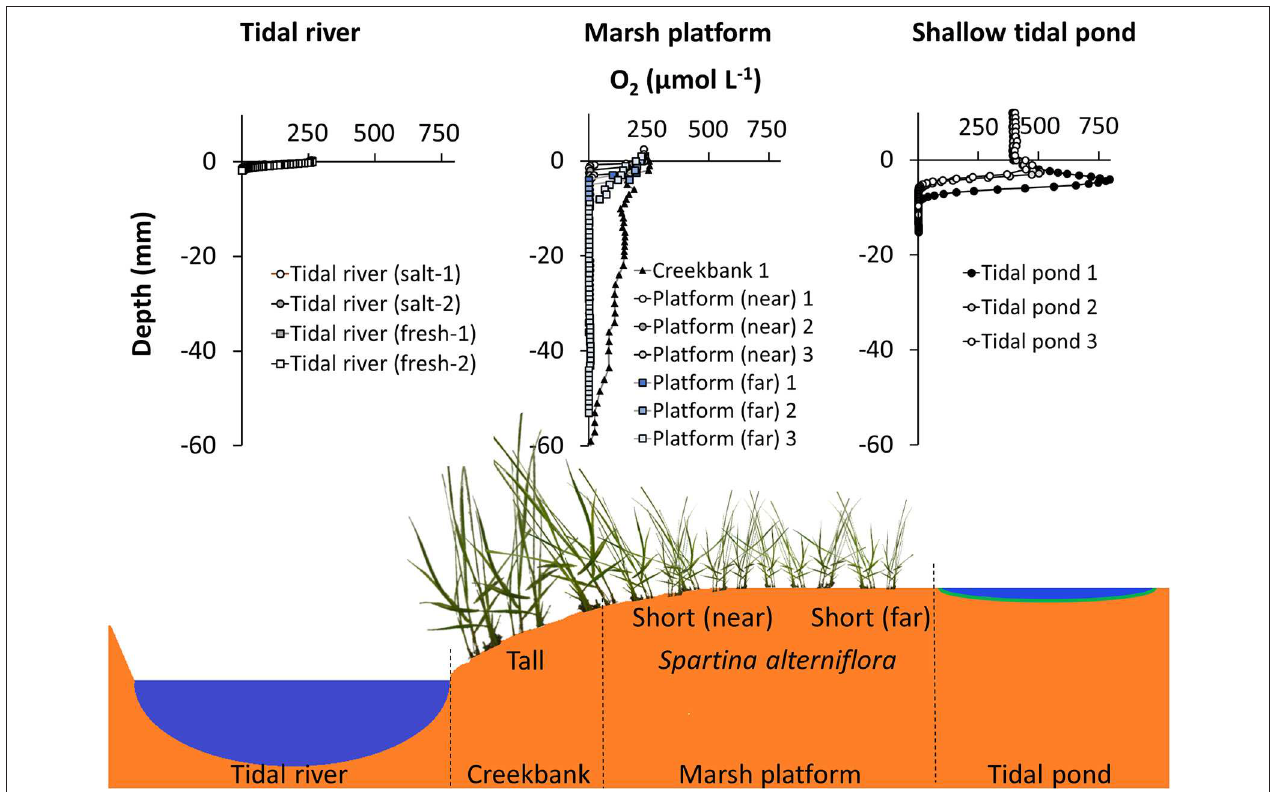
FIGURE 9 | Comparison of oxygen profiles in the sediment from different marsh habitats during daylight conditions. (Top panel, Left) Oxygen profiles from the Parker River in the Plum Island Estuary, MA, USA from a freshwater and saltwater-dominated area, respectively (Laboratory core profiling, July 2015). (Mid) Oxygen profiles from three locations on vegetated marsh platform; creekbank and two locations in the low marsh, near, and far from the creekbank. Great Sippewissett Marsh, MA, USA ( in situ profiling July 2016). (Right) Oxygen profiles in shallow tidal ponds (this study, afternoon profiles) (Bottom panel): Cross section of salt marsh ecosystem, schematically depicting the different habitats, where oxygen was profiled; tidal river, marsh platform, and tidal